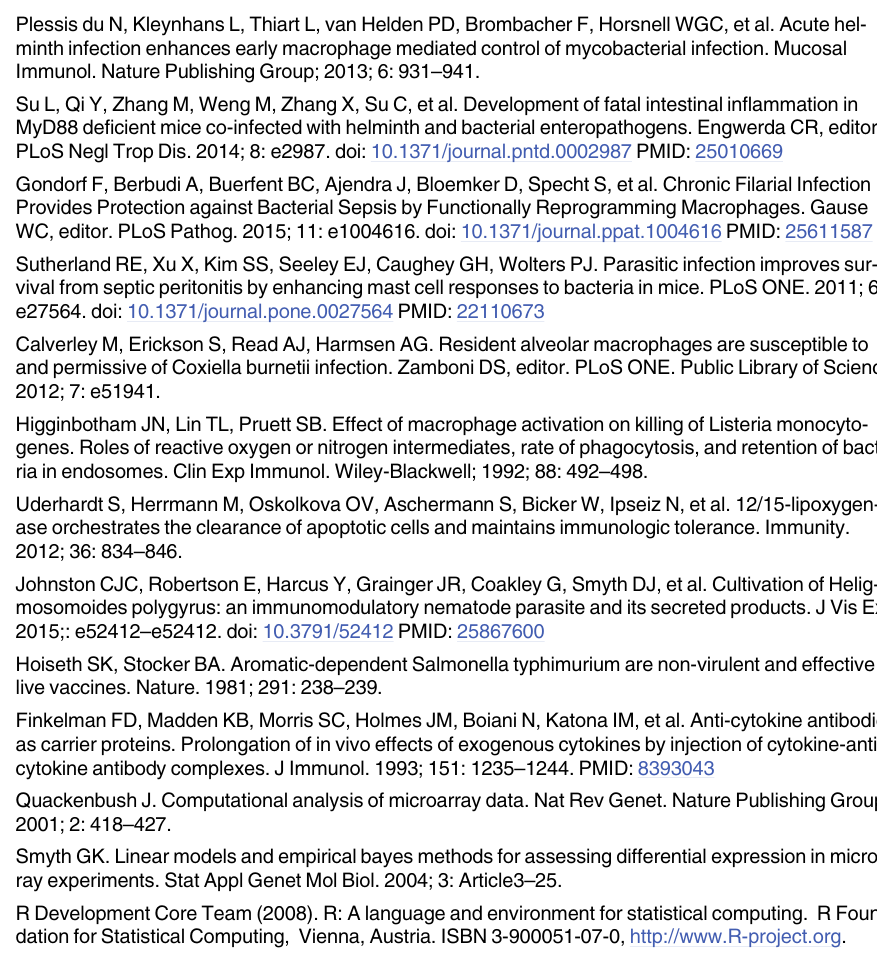
PLOS Pathogens| DOI:10.1371/journal.ppat.1006233 March 23,